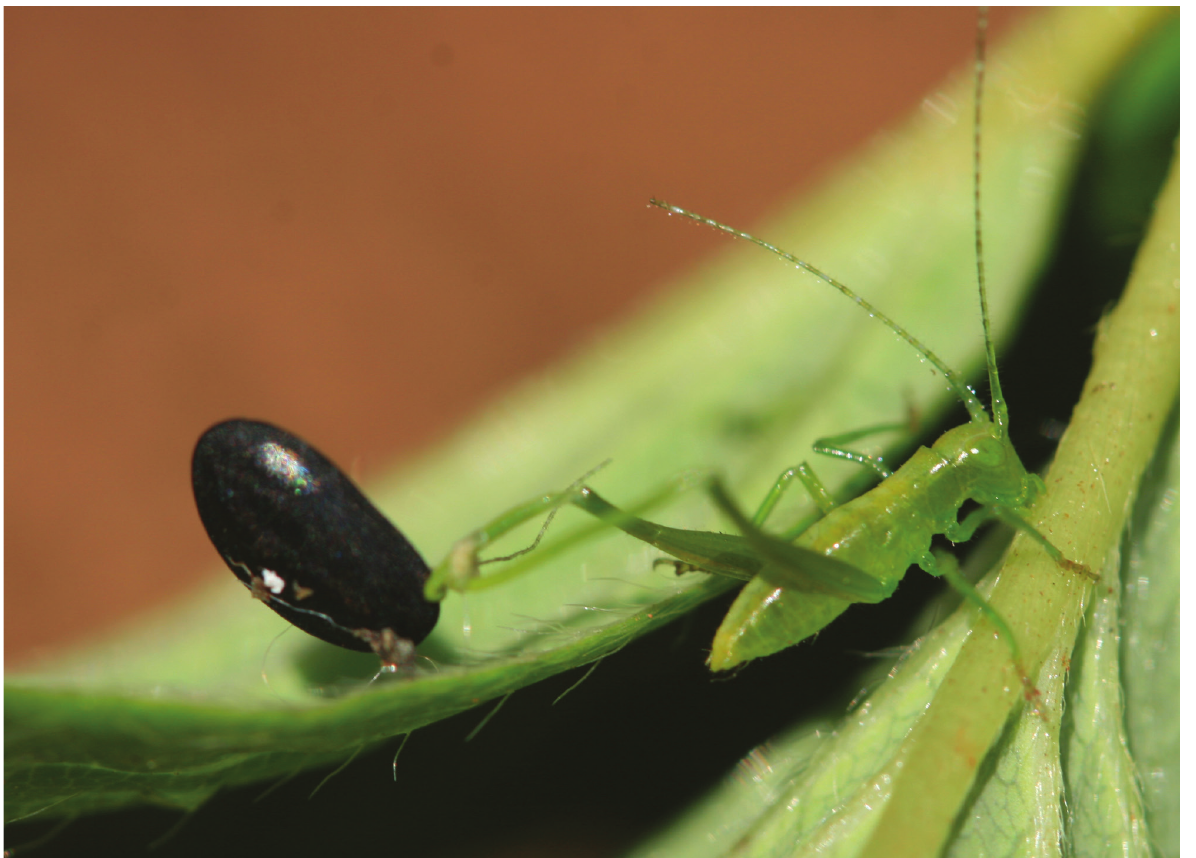
Figure 11. Hatching nymph of G. maculata